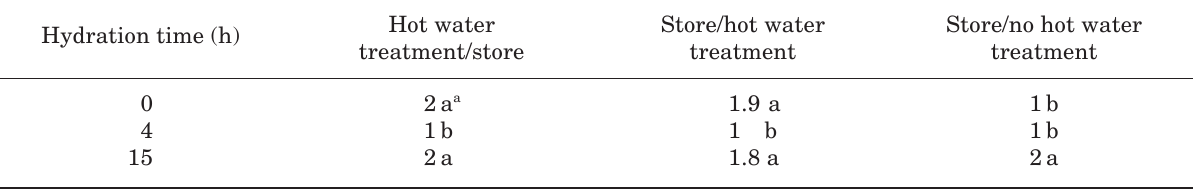
Table 2. Cultivar Chardonnay - means of root development where 1, roots absent; 2, roots<3 mm; 3, roots >3mm. Hydration time